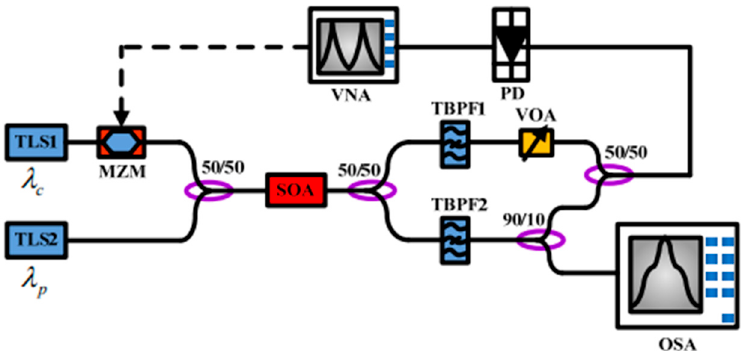
Figure 9. Laboratory install of the proposed filter [54] . VNA: Vector Network Analyser; PD: Photon